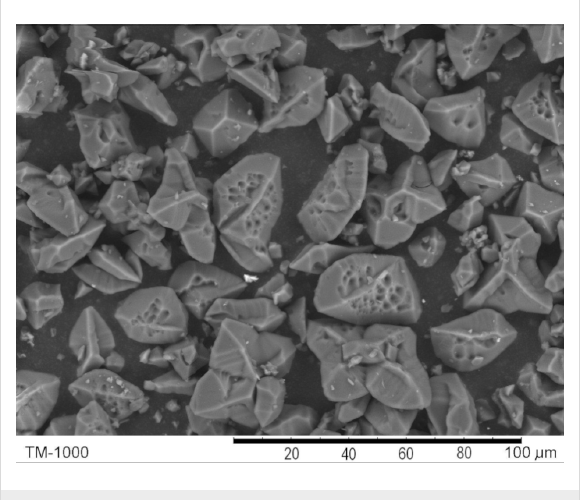
Figure 3: SEM image of F-1